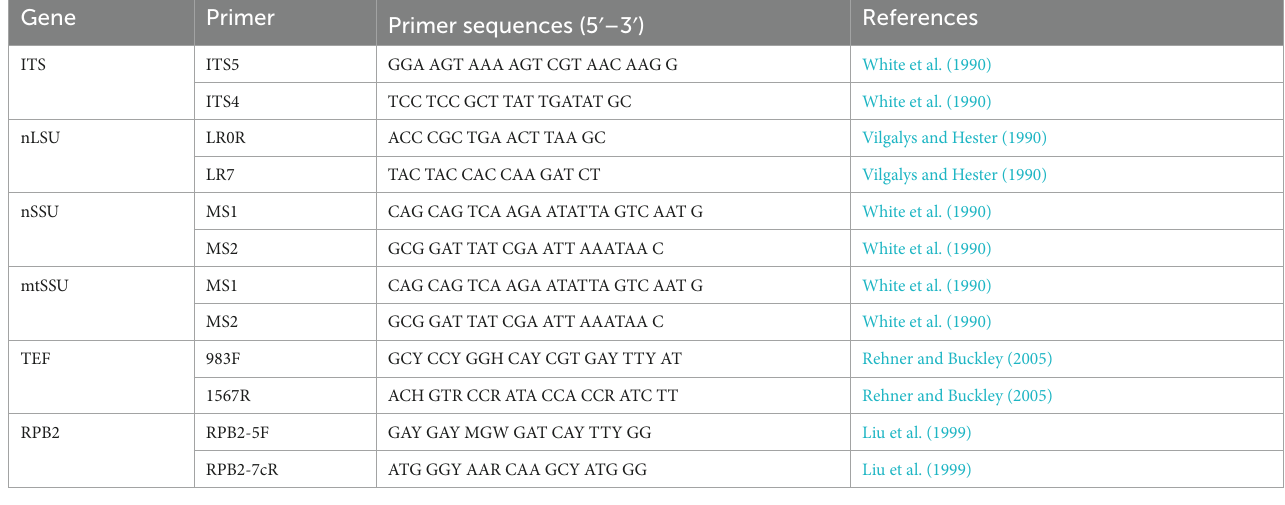
TABLE 1 PCR primers used in this study.